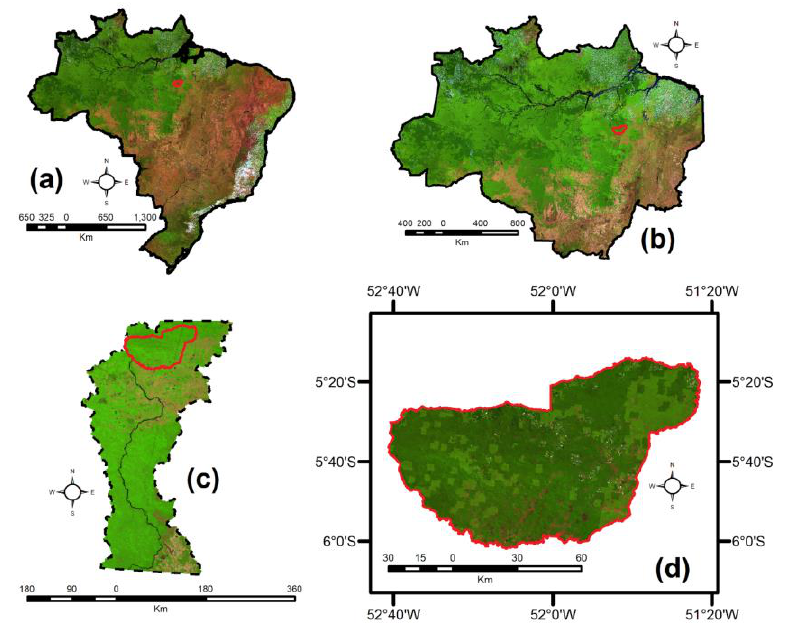
Figure 1. ( a ) Location of the Apyterewa Indigenous Land within the Brazilian territory, ( b ) Brazilian Legal Amazon, ( c ) municipality of São Félix do Xingu and ( d ) spatial location of the study area. The base map is a moderate resolution imaging spectroradiometer (MODIS) MOD09A1 product color composite R6G2B1 for the year